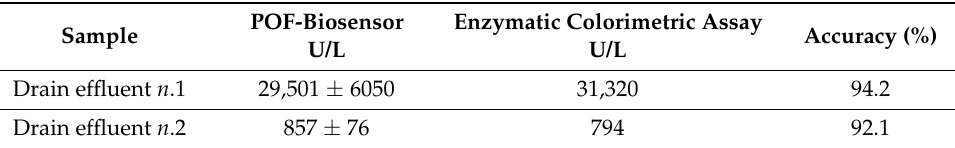
Table 4. Comparison between the determination of the amylase (U/L) made by the POF-biosensor and the enzymatic colorimetric test used as the gold standard.